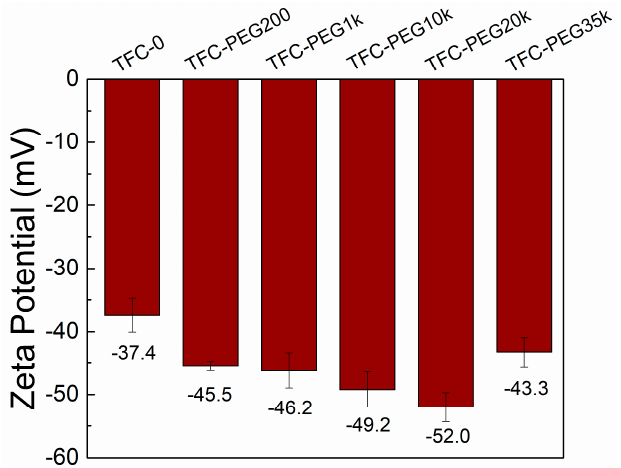
Figure 7. Zeta potential of thin-film composite membranes prepared using PEG of varying molecular weights; pH = 7.0.